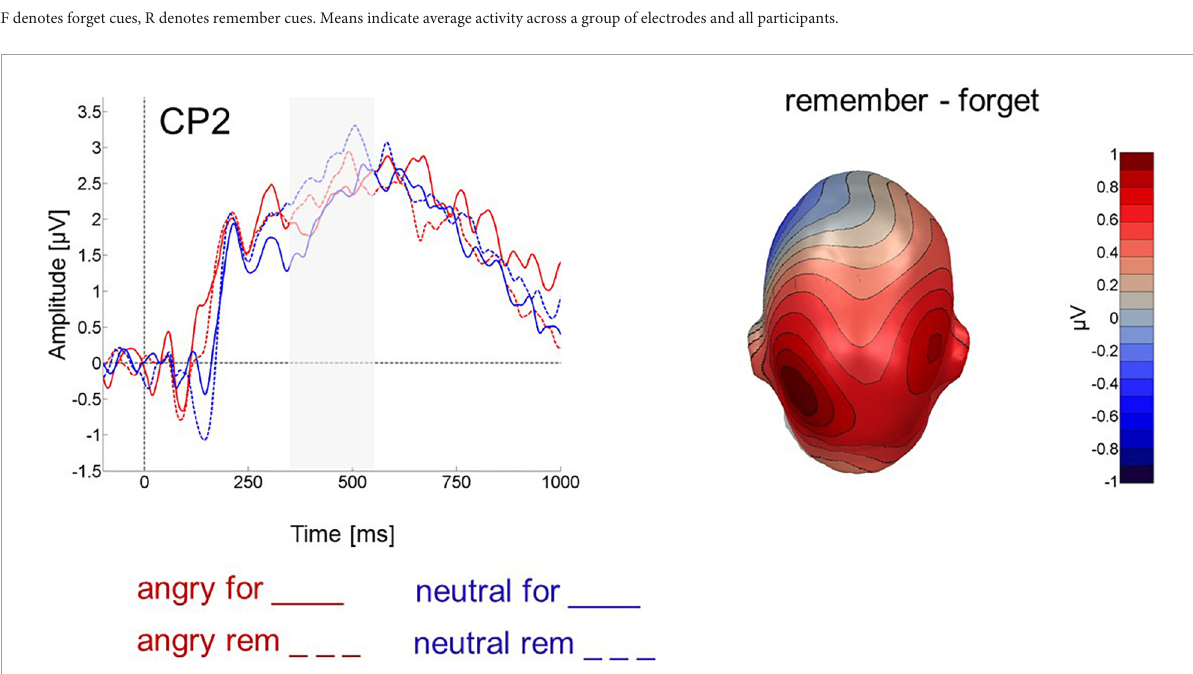
FIGURE5 Cue-evoked ERP for cues following angry (red) and neutral (blue) faces at centro-parietal electrode CP2. Forget cues are solid lines, remember cues are dashed. Right panel shows difference topography for remember minus forget cues across all 64 electrodes between 350 and 550 ms after cue